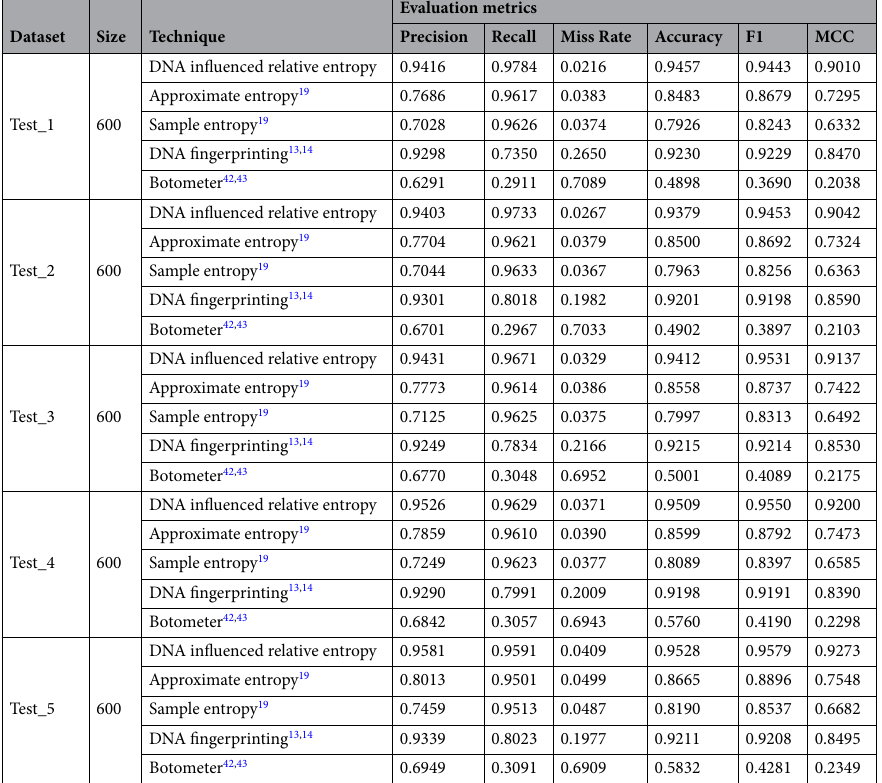
Table 3. Comparison of performance calculated by different techniques on test datasets.